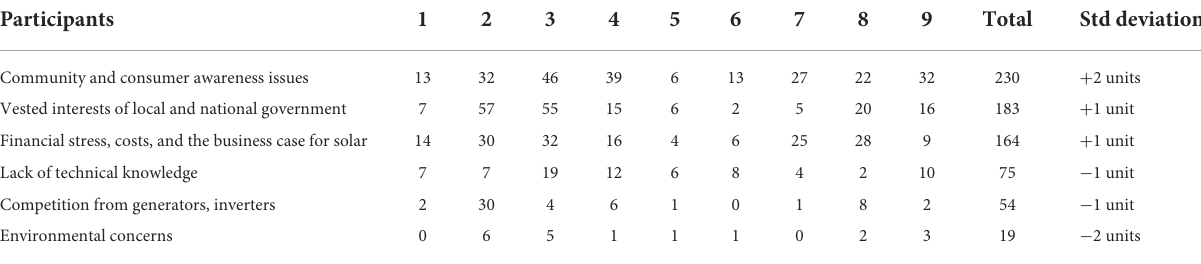
TABLE 2 Themes relating to the adoption/lack of adoption of solar PV by number of mentions per person per interview.